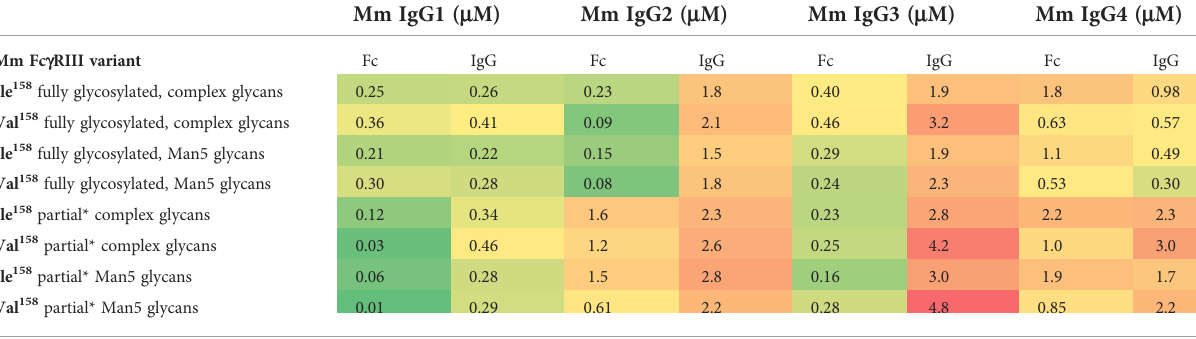
TABLE 1 Binding of the allelic Mm Fc g RIII Ile 158 and Val 158 variants to the Mm IgGs and Fcs of the Mm IgG